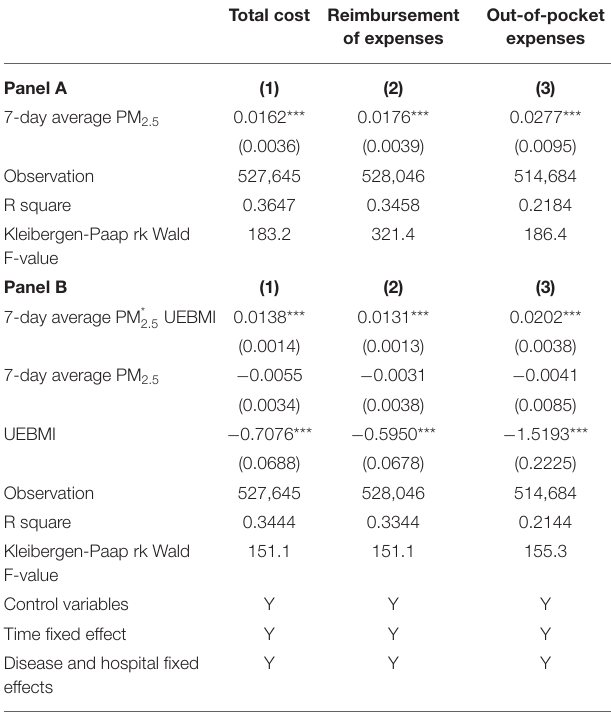
TABLE 7 | Impact of PM 2.5 on cost of visit: further analysis, consider reimbursement.